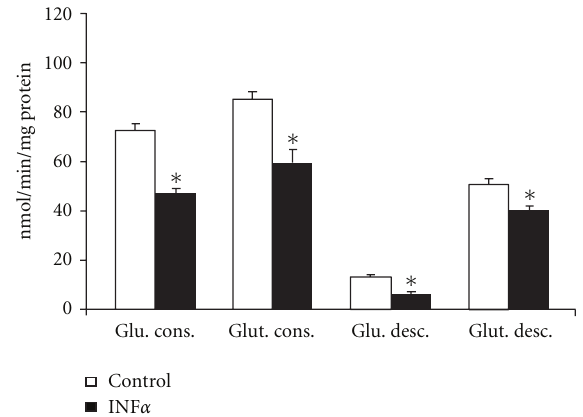
Figure 2: Consumption and decarboxylation of glucose and glutamine by mesenteric lymphocytes cultured in the presence or absence of IFN α . The results are expressed as nmol/min per mg of protein and represent the mean ± SEM of 9 experiments. ∗ P < . 05 for comparison with the control (C)